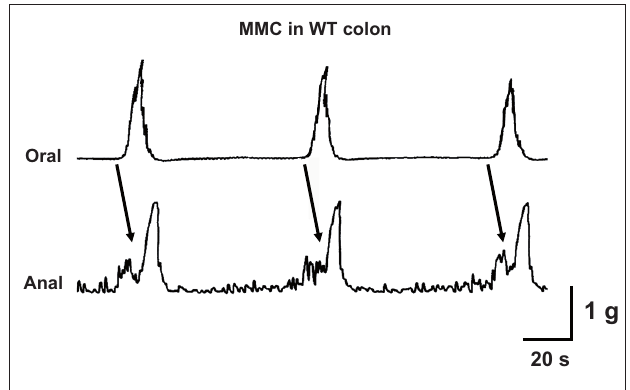
Figure 3 | representative recording of three cycles of the colonic MMC in vitro . Contractions originated at the oral end of a colonic segment and propagated to the anal recording site. Arrows indicate propagated contractions. Tissue obtained from a WT mouse.